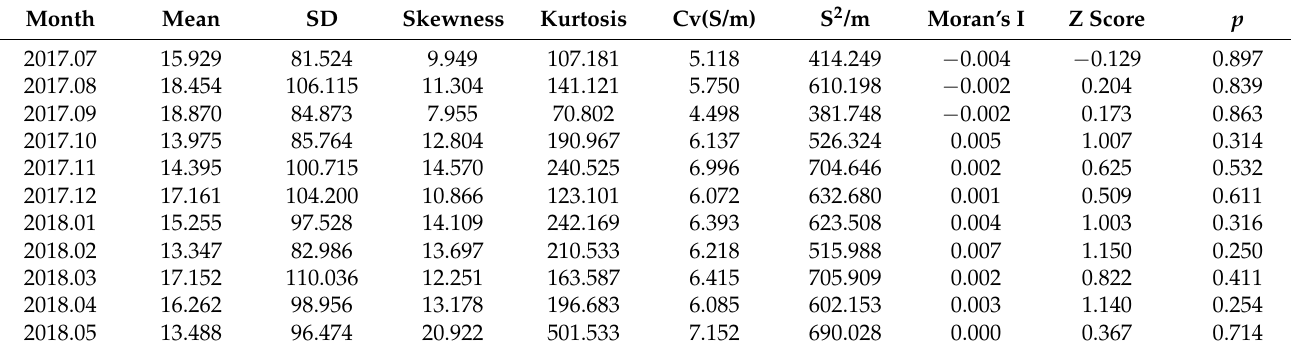
Table 2. Parameter statistics of the effort invested in purse seine